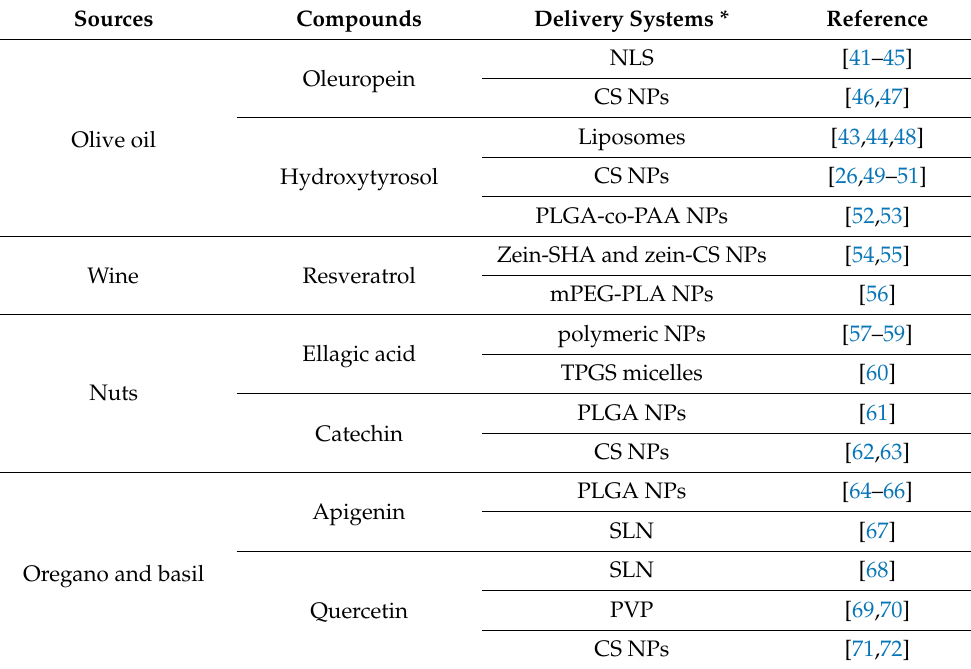
Table 1. Principal MD bioactive polyphenols and their vehicles